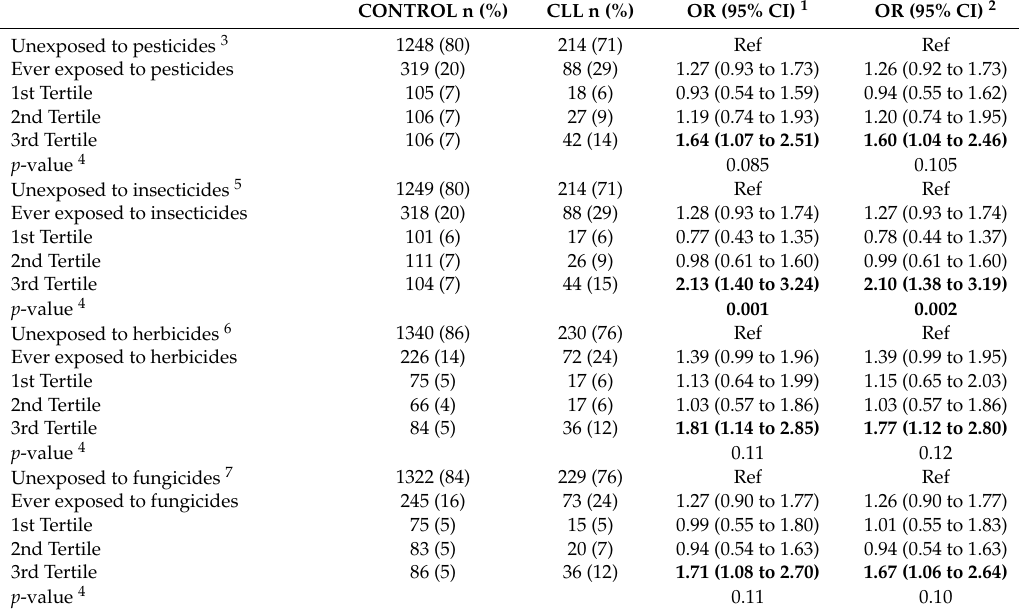
Table 2. Odds ratios (OR) and 95% confidence intervals (CI) of CLL and cumulative exposure score (CES): overall and by pesticide